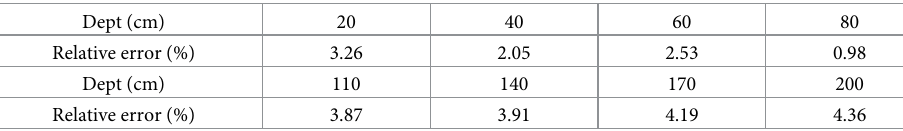
Table 2. Relative error of measured values for water